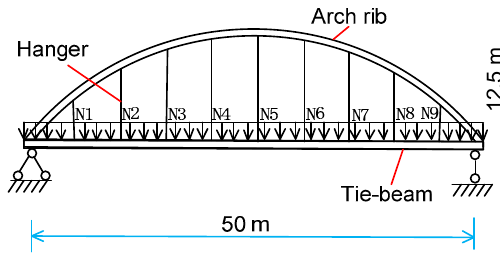
Figure 3. Diagram of the two-dimensional FEM. Table 1. Eighteen damage conditions simulated by FEM. Damage Type Damage Case No. Damage Hanger No.